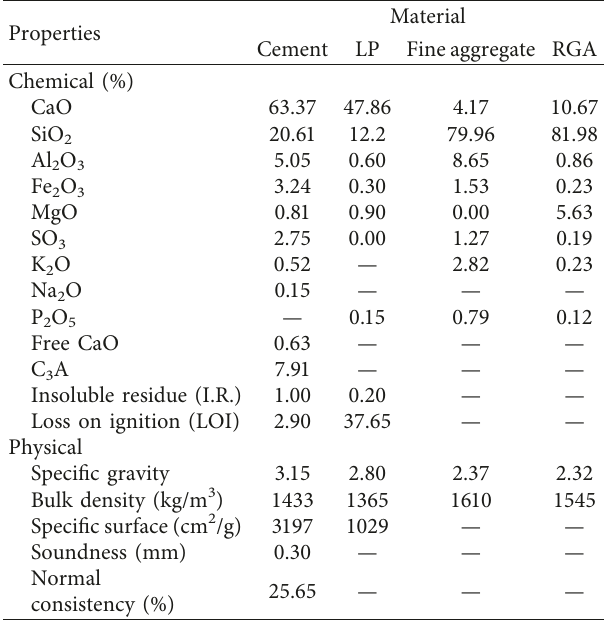
Table 1: Chemical composition and physical properties of the constituent materials.